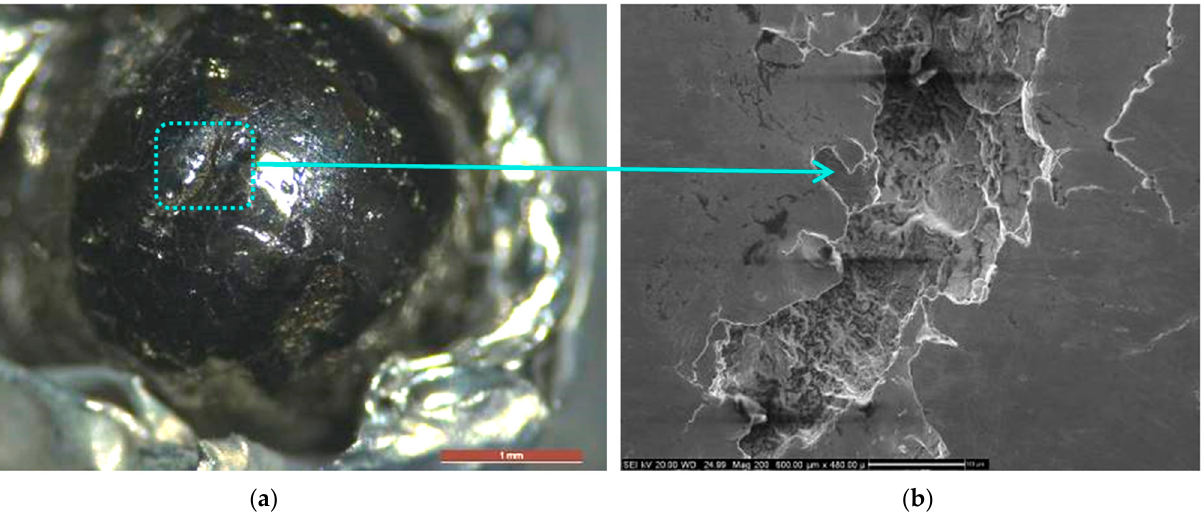
Figure 6. Typical heavy damage appearance of the balls: ( a ) macroscopic appearance of contact fatigue spalling; ( b ) fan-shaped morphologies, lamellar damage and